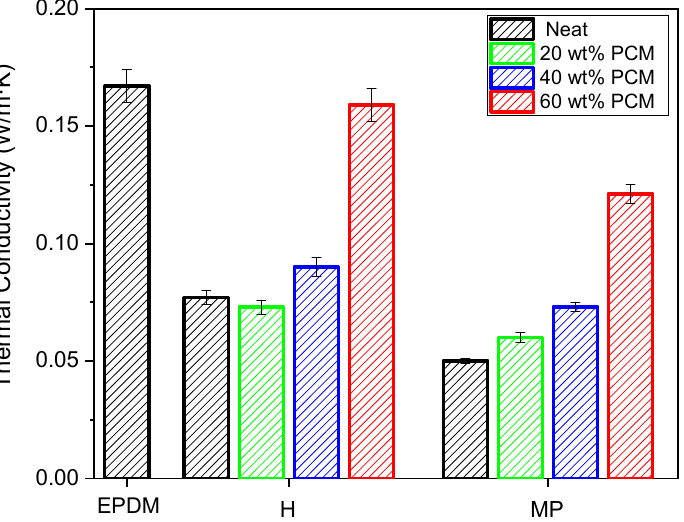
Figure 6. Results of thermal conductivity tests on bulk EPDM sample and on the prepared foams.